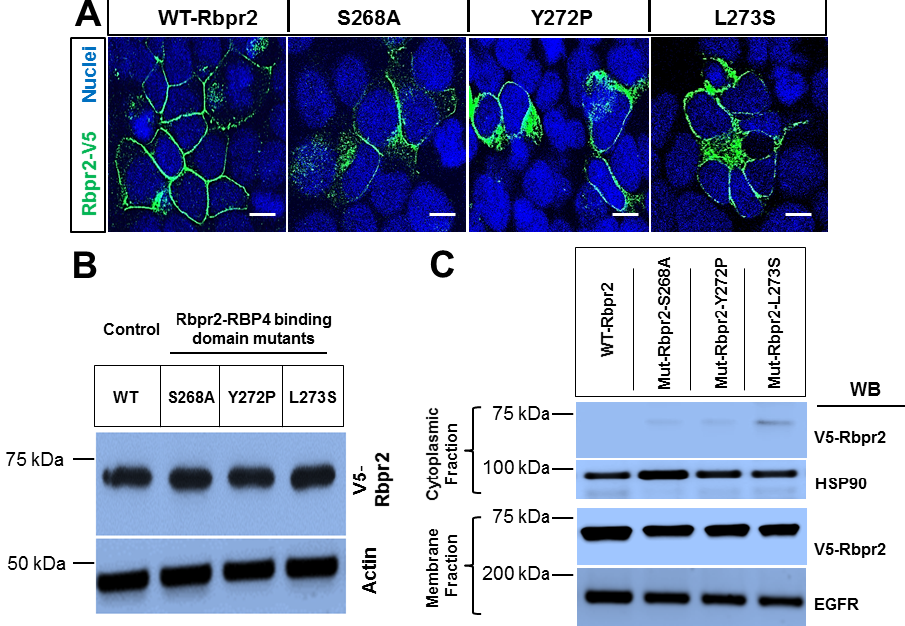
Figure 3. Analysis of expression patterns and membrane trafficking capabilities of zebrafish Rbpr2 mutants a ff ecting the proposed RBP4 binding domain. ( A ) Staining of zebrafish Rbpr2-RBP4 binding domain variants in NIH3T3 cells to examine membrane expression patterns using the V5-antibody. Nucleus, DAPI, blue; Rbpr2-V5, Green. Scale bar = 50 µ m. ( B ) Representative Western blot images of WT-Rbpr2 and Rbpr2-RBP4 binding domain mutants. Anti-V5 antibody was used to detect the